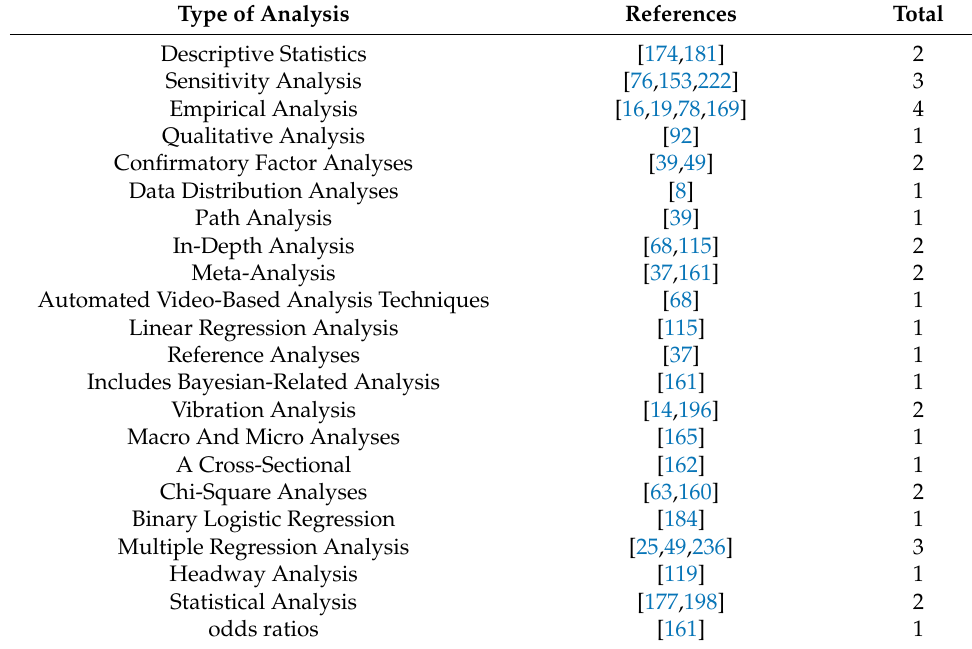
Table 7. References of type of